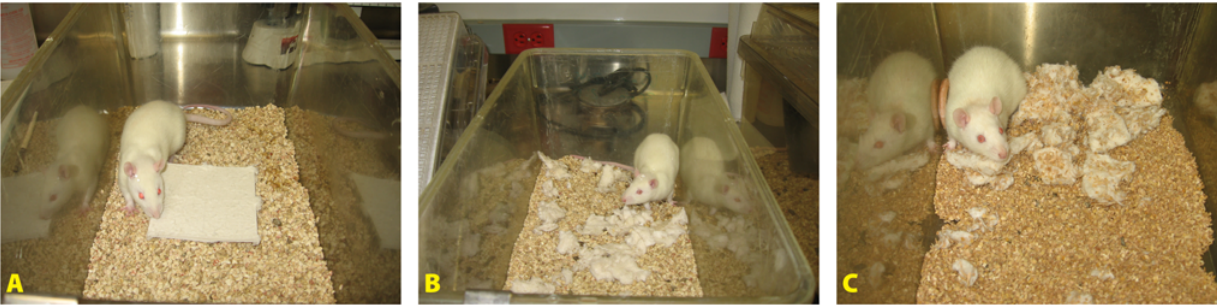
Figure 1. Nestlet ‘‘treatment’’ of isolation reared rats. Twice weekly cages are changed and replaced with a new Nestlet (A), the Nestlet is shredded by the rat prior to forming the nest (B), and then the rat spends time resting in the formed nest